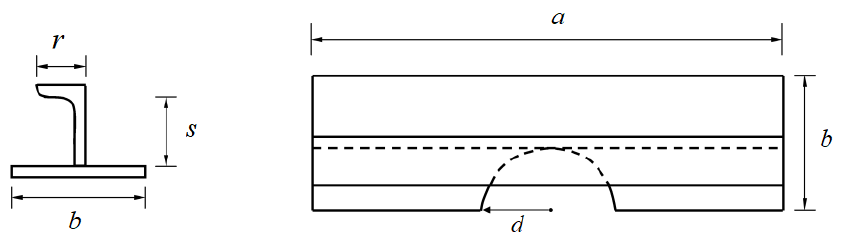
Figure 9. Simply supported stiffened plate with semi-circular opening (Adapted from [27]).